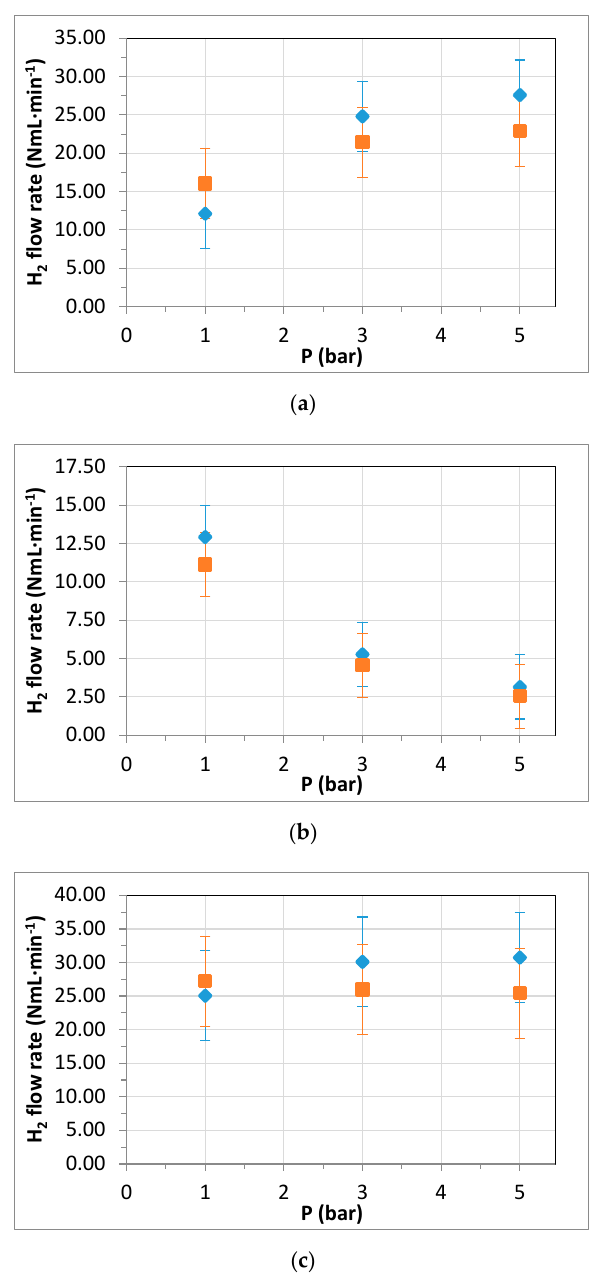
Figure 4. Effect of pressure in OMW–EtOH co-reforming experiments (T = 450 °C, EtOH concentration Figure 4. E ff ect of pressure in OMW–EtOH co-reforming experiments (T = 450 ◦ C, EtOH concentration 7.5% v / v , feed: 15 g/h OMW–EtOH mixture and 15 mL/min carrier gas): ( a ) permeate, ( b ) retentate, 7.5% v / v, feed: 15 g / h OMW–EtOH mixture and 15 mL / min carrier gas): ( a ) permeate, ( b ) retentate, and and ( c ) total produced hydrogen. Diamonds ( ) represent experiments with nitrogen, while squares ( c ) total produced hydrogen. Diamonds ( (cid:117) ) represent experiments with nitrogen, while squares ( (cid:4) ) are ( ) are obtained with air as the carrier gas. obtained with air as the carrier